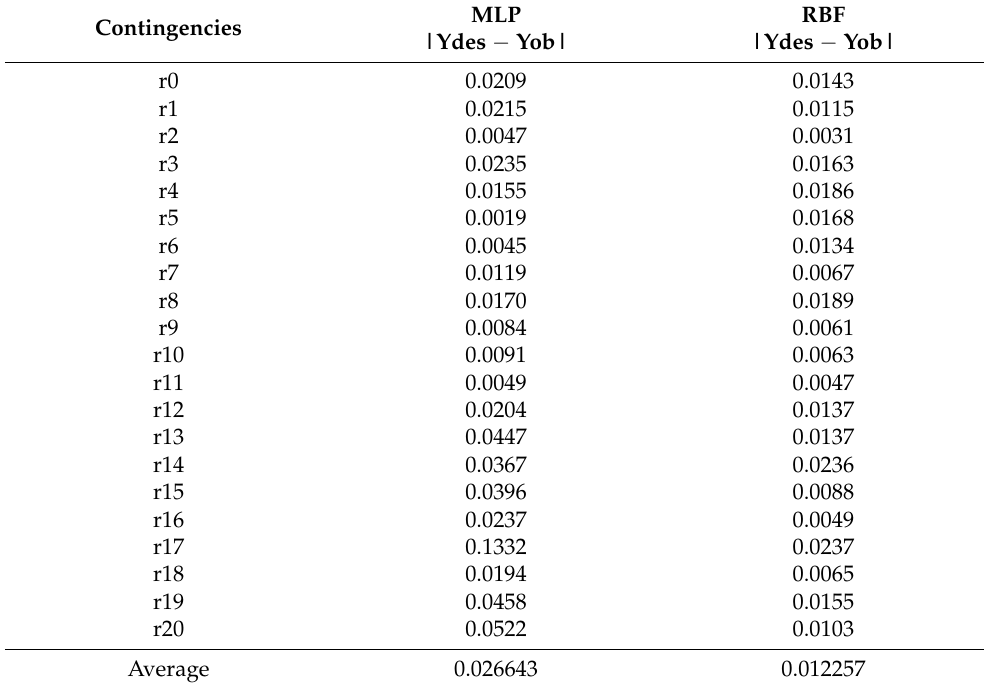
Table 3. Differences between the maximum loading point values of bus 14 obtained via MLP and RBF network for each